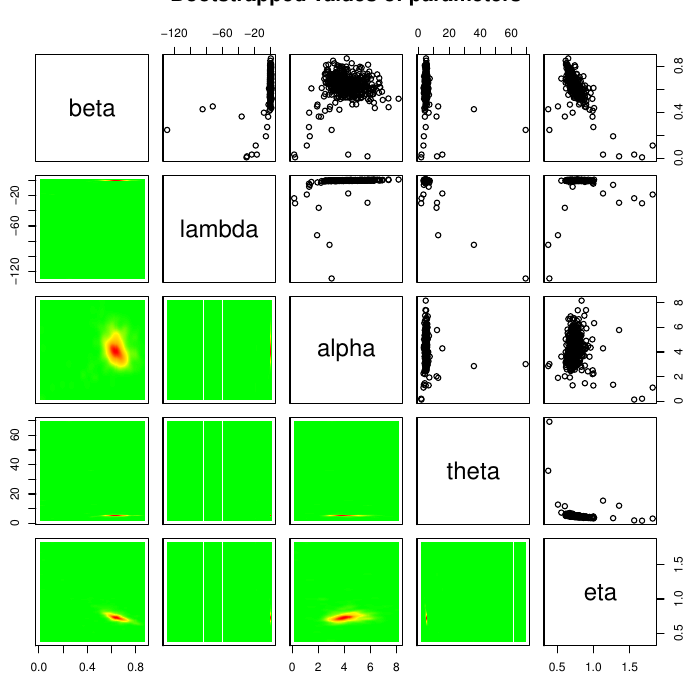
Figure 7 – Parametric bootstrapped values of parameters of GOTTS-E distribution for the second data